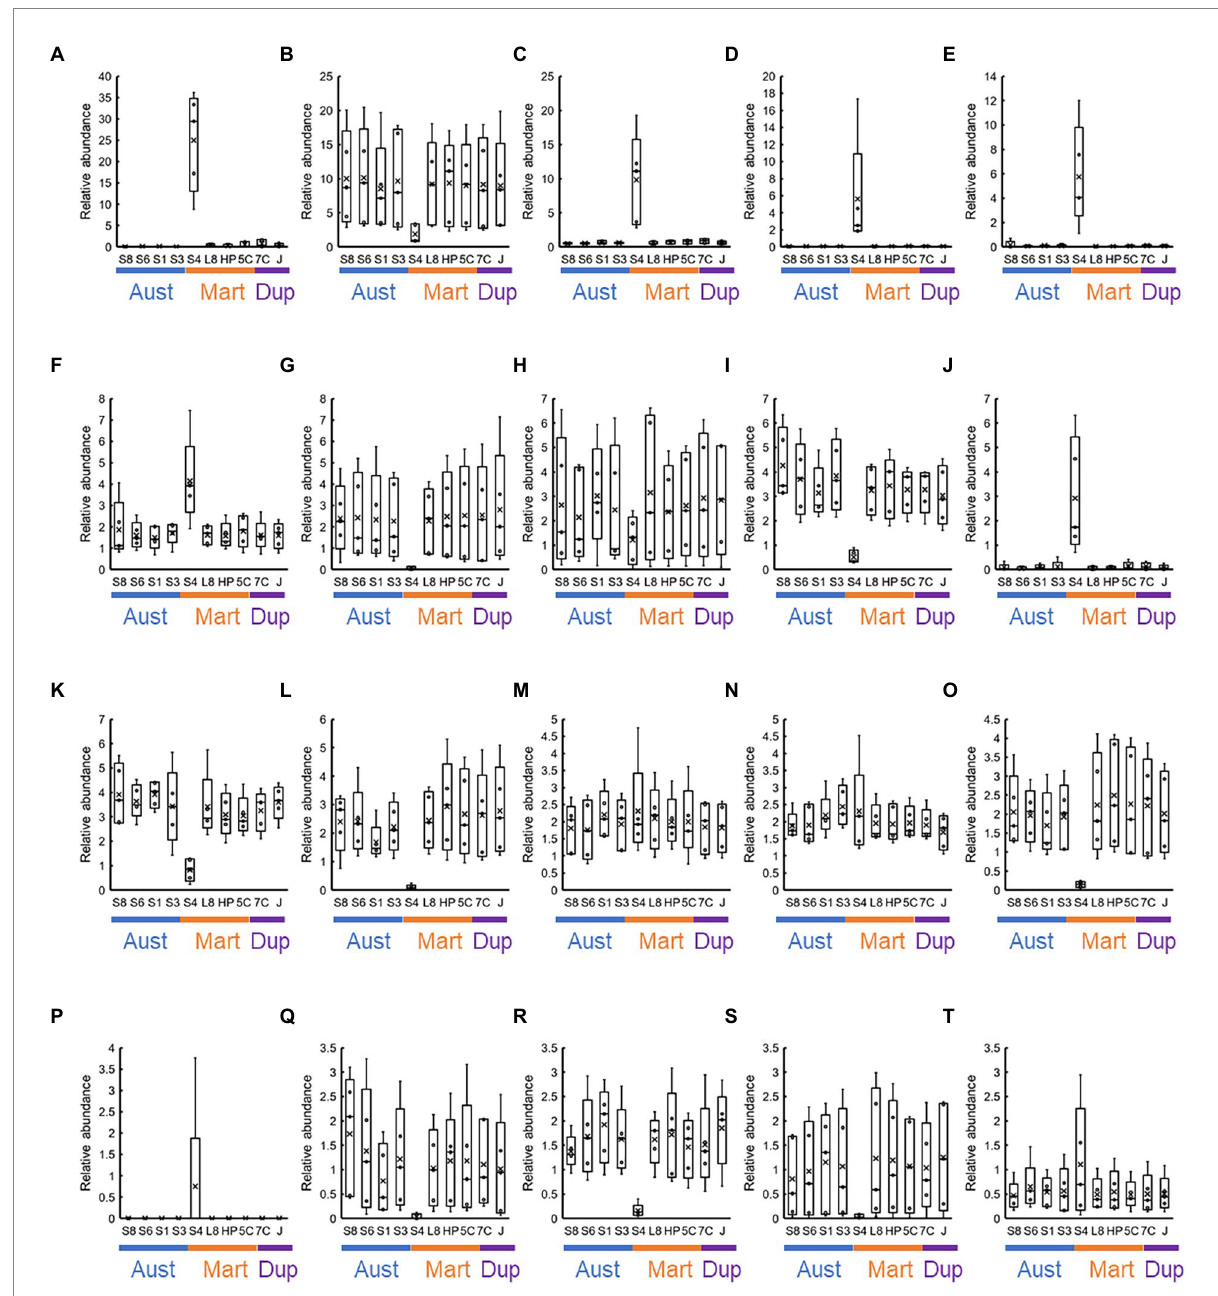
FIGURE 9 Co-abundance analysis of the 20 most abundant OTUs in each stainless steel. Relative abundances at the genus level in each stainless steel ( n = 5) are represented as box-and-whisker plots. The line in the middle of the box, top and bottom of the box, whiskers, and cross symbols represent the median, 25 and 75 percentiles, min-to-max values, and average, respectively. (A) Family Beggiatoaceae ; (B) Nitrospira ; (C) class Gammaproteobacteria ; (D) Candidatus Tenderia; (E) family Sideroxydans ; (F) family Comamonadaceae ; (G) phylum Myxococcota ; (H) class Cyanobacteriia ; (I) Vicinamibacteraceae ; (J) Ferritrophicum ; (K) family Gemmataceae ; (L) order Vicinamibacterales ; (M) family Microscillaceae ; (N) phylum Planctomycetota ; (O) order Burkholderiales ; (P) Leptospirillum ; (Q) Luteitalea ; (R) family Nitrosomonadaceae ; (S) family Anaerolineaceae ; and (T) order Rhizobiales ; S8, S30400; S6, S31600; S1, Casting S31600; S3, S30300; S4, S40300; L8, S42000; HP, S41426; 5C, 15% Cr; 7C, 17% Cr; and J,